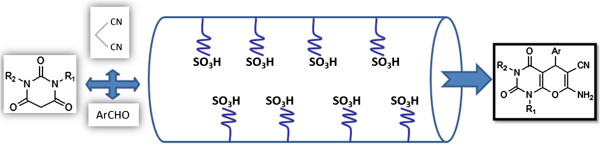
SBA-Pr-SO3H act as a nano-reactor in this reaction.